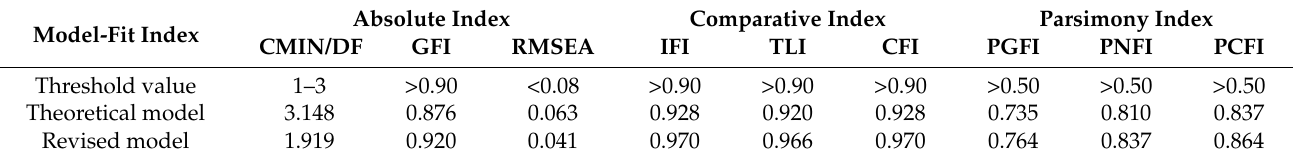
Table 5. Goodness-of-fit indices.